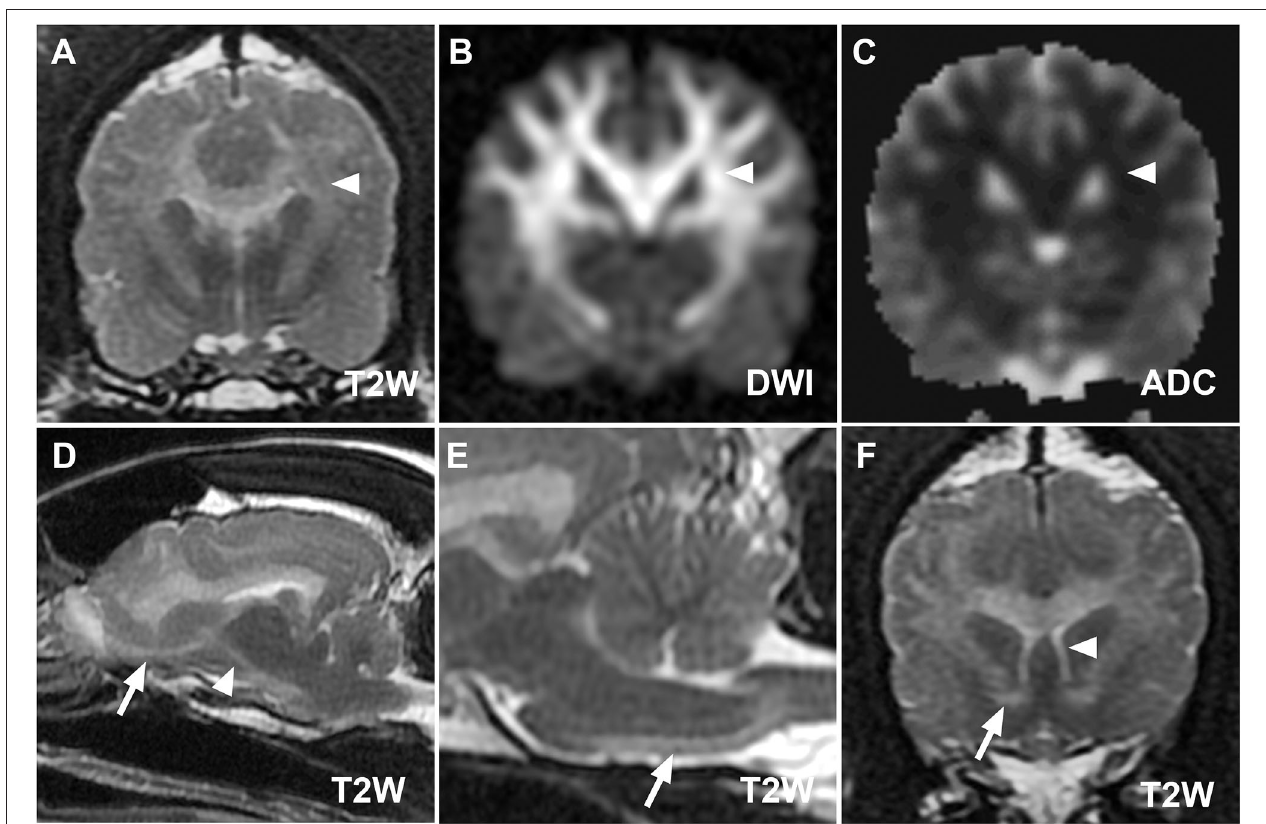
FIGURE 2 | (A–C) MR images at the level of the thalamus from case 1 demonstrating restricted diffusion of defined lesions. Hyperintensity of corona radiata (white arrowheads) on T2W (A) and diffusion-weighted imaging (DWI) (B) images with hypointensity on the corresponding apparent diffusion coefficient map (C) is consistent with restricted diffusion. Parasagittal (D) and midsagittal T2W images (E) highlight the descending [ (D) , white arrowhead] and pyramidal components [ (E) , white arrow] of the corticospinal tract. The olfactory tract [ (D) , white arrow], rostral commissure [ (F) , white arrow, transverse T2W image], and columns of the fornix [ (F) , white arrowhead] ventral to the hyperintense corpus callosum are also clearly